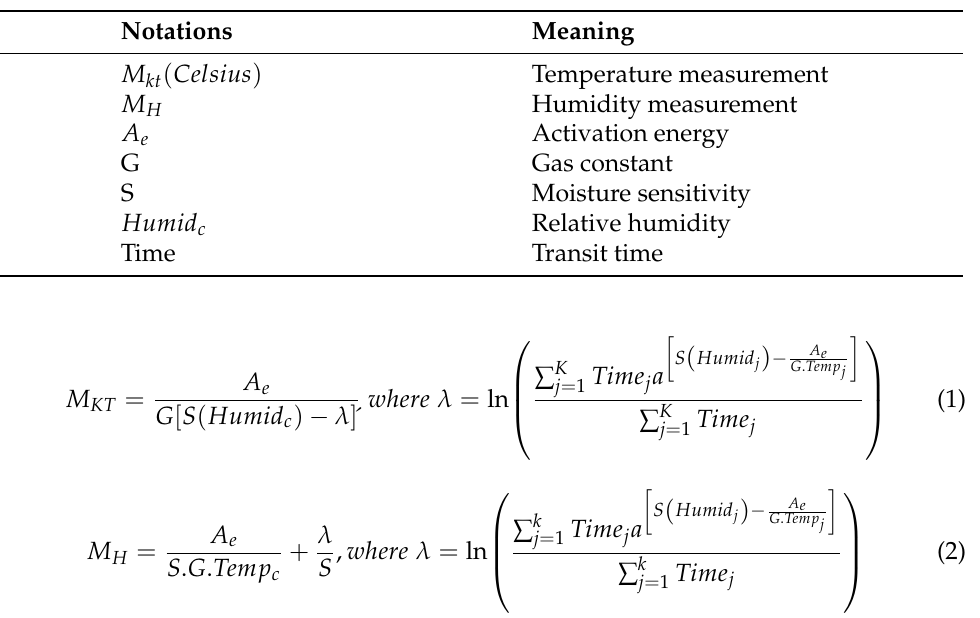
Table 2. Notations used for fuzzy food quality